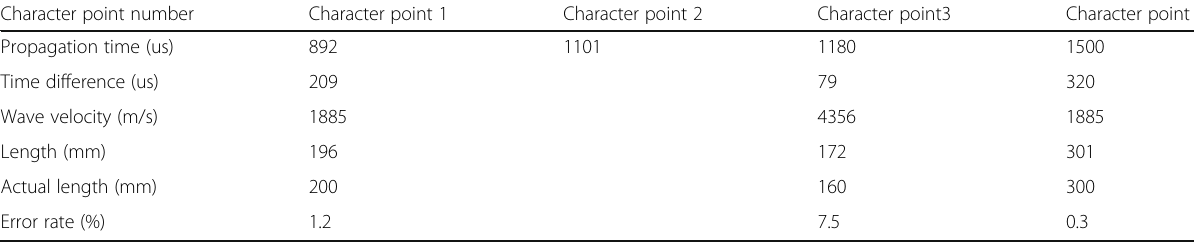
Table 4 Non-destructive detect recognition parameters of sample